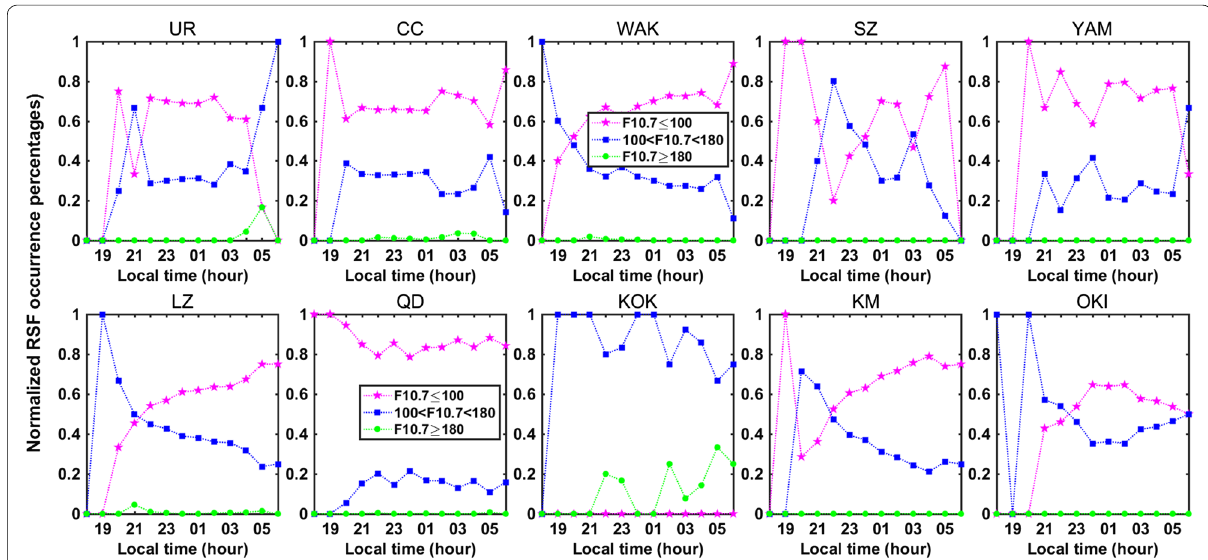
Fig. 8 Variations in normalized RSF occurrence percentages on different F10.7 index levels; magenta lines represent the high solar activity, blue lines represent the medium solar activity, and green lines represent the low solar activity